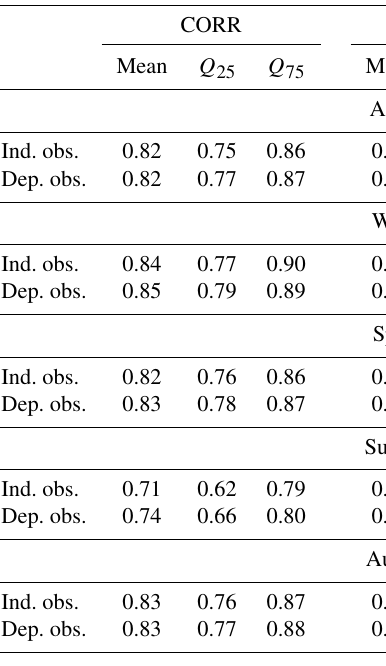
Table 2. The annual and seasonal correlation (CORR), relative mean absolute error (MAEr) and ROC skill area (RSA) of SAFRAN compared to the independent (ind.) and dependent (dep.) observations for the period